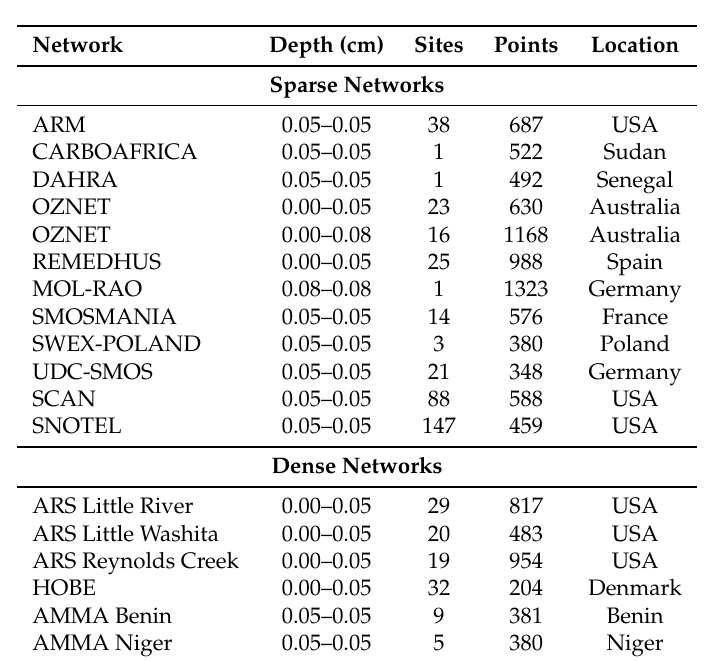
Table 1. In situ networks used in this study. The depths are quoted as two numbers: the first one is the upper depth, and the second one is the lower depth of the sensor. Both numbers are equal when the sensor is placed horizontally. The third column gives the number of sensors remaining for each network after applying all of the criteria used for the evaluation that are discussed in Section 3. The third column gives the average number of points in the times series for each network that satisfies the evaluation